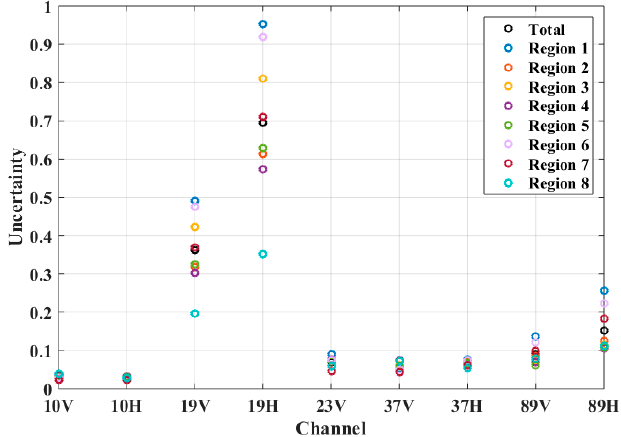
Figure 4. Regional and averaged standard uncertainty (Kelvin) for each channel.